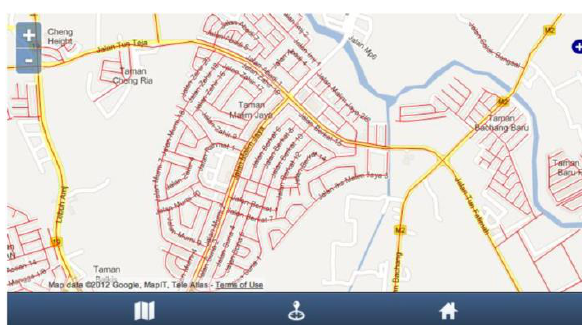
Figure 12. The Jalan Raya Using “EPSG: 3375” Layer